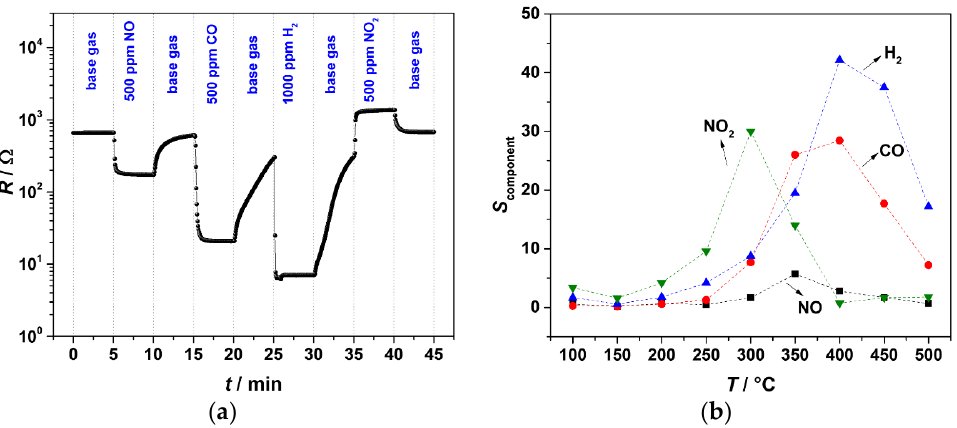
Figure 6. ( a ) Resistance change of AD-coated SnO 2 sensor at 400 °C in the presence of different gas components in flowing base gas (20% O 2 in N 2 and 3% H 2 O) and ( b ) response of the AD-coated SnO 2 sensor towards the gas components between 100 °C and 500 °C .